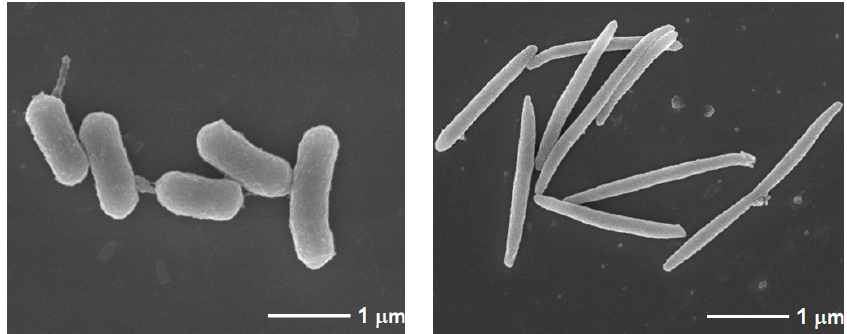
Figure 1. Electron microscopic image of Porphyromonas gingivalis and Fusobacterium nucleatum. ( A ) P. gingivalis is an oral Gram-negative black-pigmented strict anaerobic bacterium. It is frequently found in the plaque biofilms on tooth surfaces from individuals with periodontal diseases. P. gingivalis is implicated in periodontal disease and systemic diseases. Its pathological effects are mediated by a variety of virulence factors including lipopolysaccharide (LPS), fimbriae, proteases, and short-chain fatty acids such as butyric acid (BA). ( B ) F. nucleatum is a Gram-negative anaerobic rod bacterium and a common resident of the human mouth and gut. This bacterium causes a wider variety of inflammatory diseases such as periodontitis, appendicitis, inflammatory bowel diseases, and colorectal cancer.